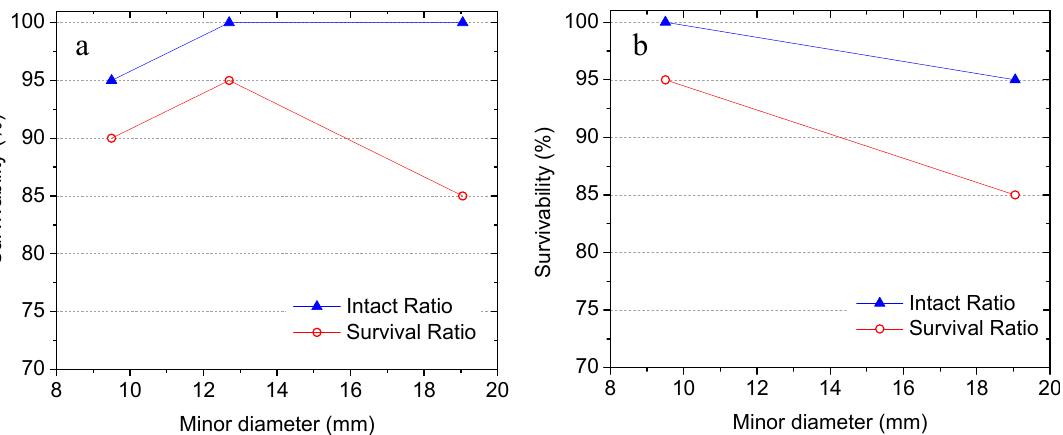
Figure 5. Influence of capsule size on survivability: ( a ) aspect ratio of 1.5:1:1, and ( b ) aspect ratio of 2:1:1.